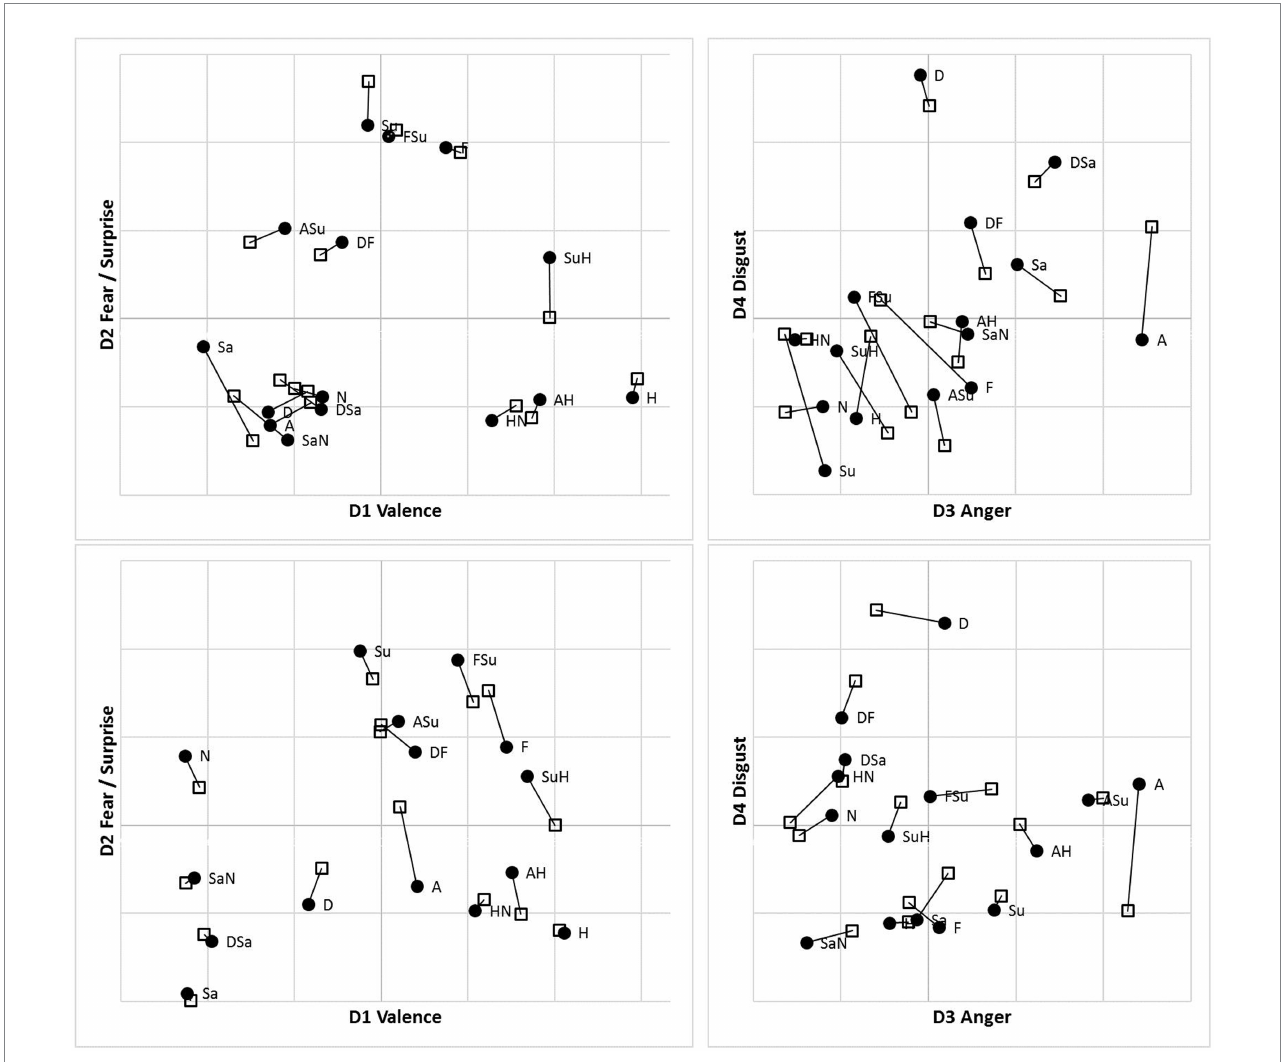
FIGURE 7 Four-dimensional MDS solutions for MO (top) and WF (bottom) stimulus sets, from “filtered” RT*( i , j ) medians sim_d ij and diss_d ij , pooling two observers for each stimulus set and superimposing solutions for Upright ( ● ) and Inverted ( □ ) observation (linked by lines). Projection on D1D2 (left) and D3D4 (right)